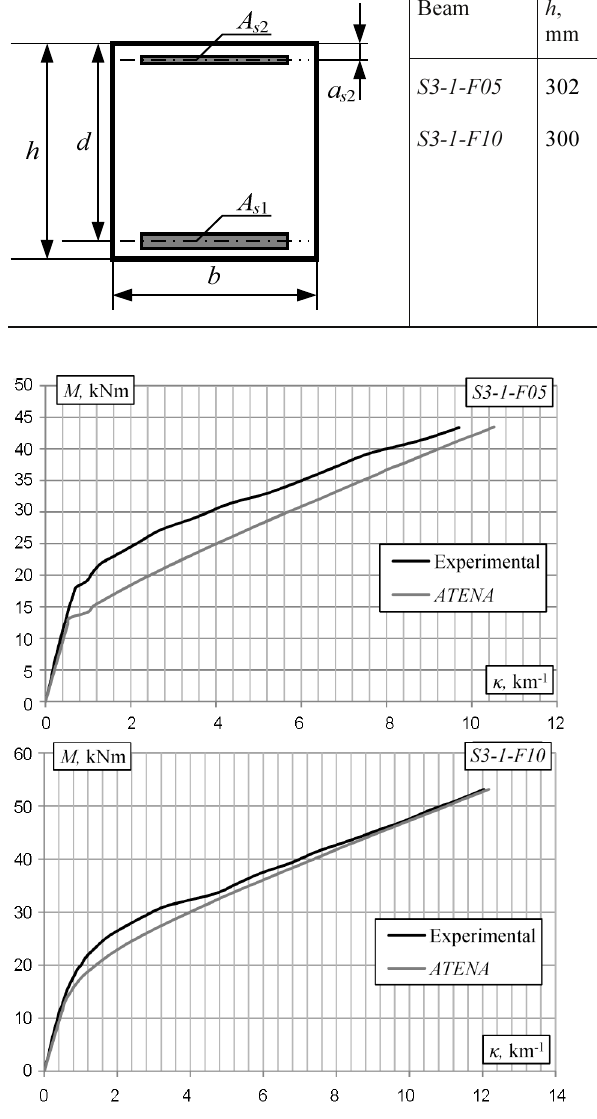
Fig. 12. Deformation analysis results on full-scale